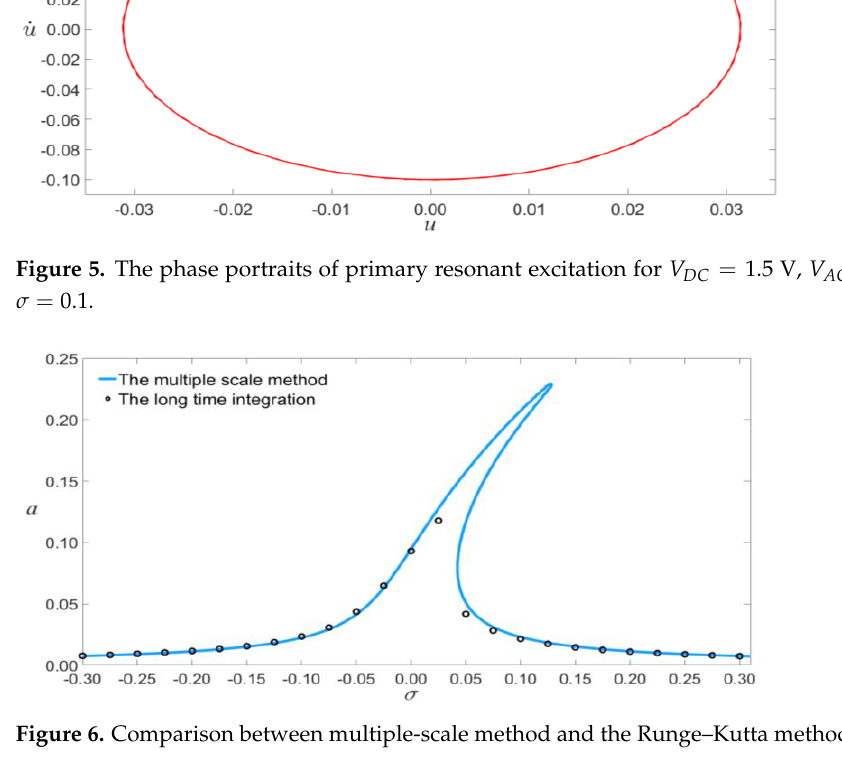
Figure 6. Comparison between multiple-scale method and the Runge – Kutta method.